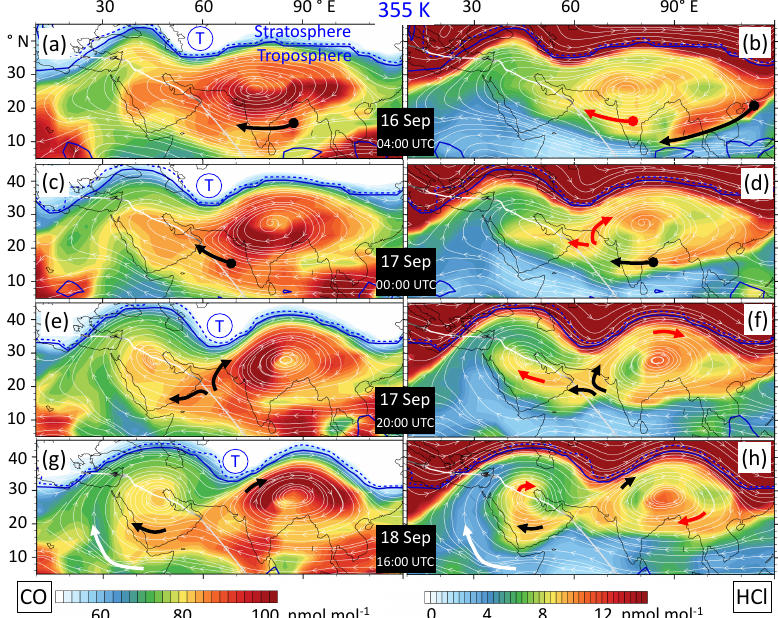
Figure 13. Sequence of simulated tracer fields at 355K, illustrating the stirring associated with the splitting-up event of the ASMA that occurred during the HALO ESMVal campaign in September 2012. Streamlines (grey) represent instantaneous wind fields, and arrows high- light the redistribution of selected air masses. CO mainly originates in the ASMA interior and HCl serves as a proxy with which to track the ASMA fringe. The sequence starts with an elongated anticyclone on 16 September 2012. Then a tropopause trough (T) evolves from the west along the northern ASMA flank. The anticyclone succumbs to the perturbation and splits up into a Tibetan and an Iranian part, shortly after the HALO flight from Male to Larnaca had passed through. A part of the increased CO interior region is entrained by the outer streamlines of the Iranian part, while the rest of the patch is diverted into the interior of the Tibetan anticyclone (black arrows in the left panels). The evolution of freshly entrained HCl (black arrows) and an older patch (red arrows) are shown in the right panels. We also note entrainment of tropospheric air by southerly winds at the western flank (white